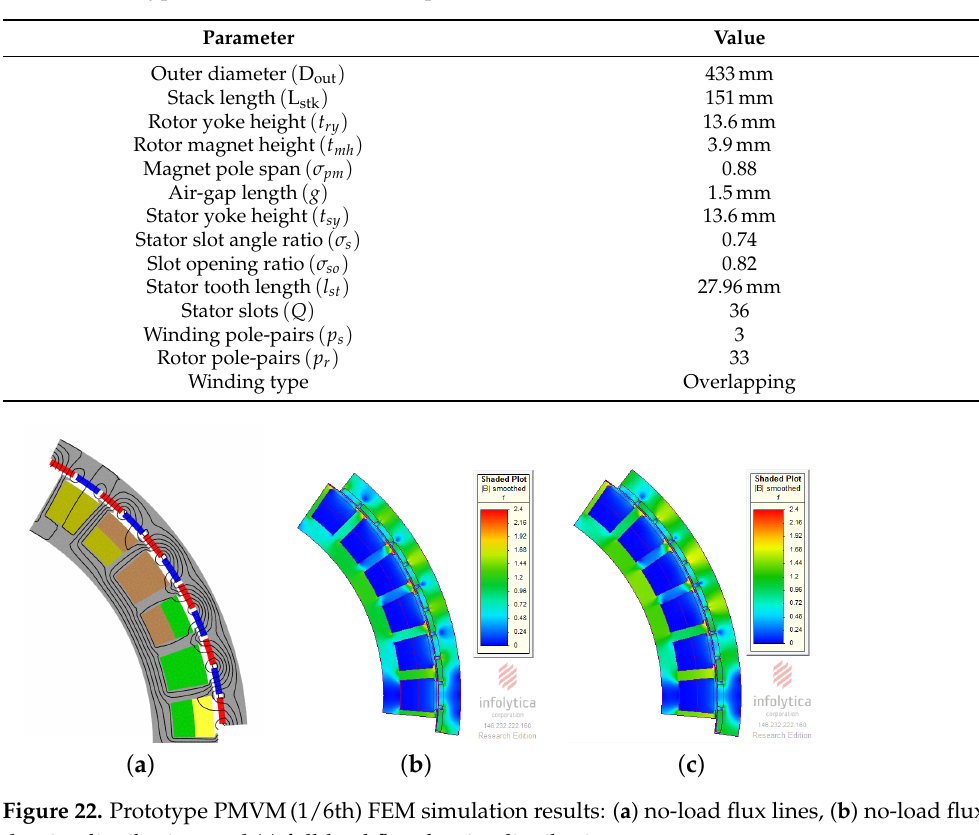
Table 7. Prototype machines’ dimensional parameters.